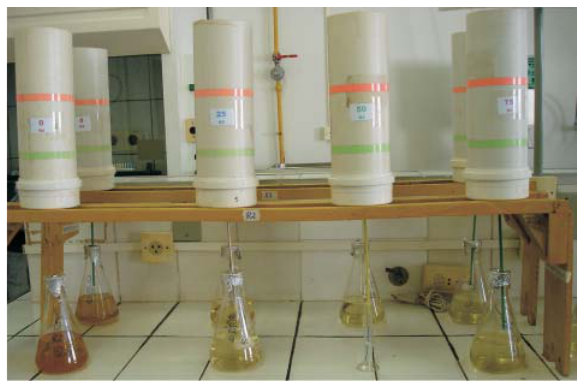
Figure 1. PVC columns with samples of natural soil and soil-sludge